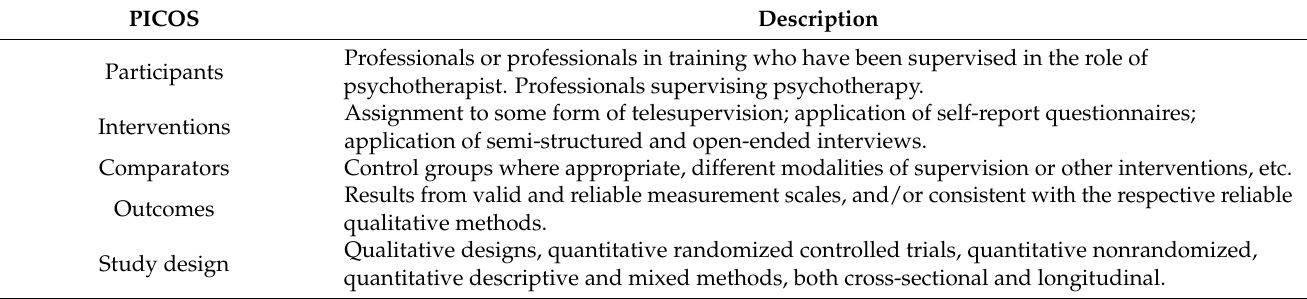
Table 1. Eligibility criteria using PICOS (participants, interventions, comparators, outcomes, and study design). PICOS Description